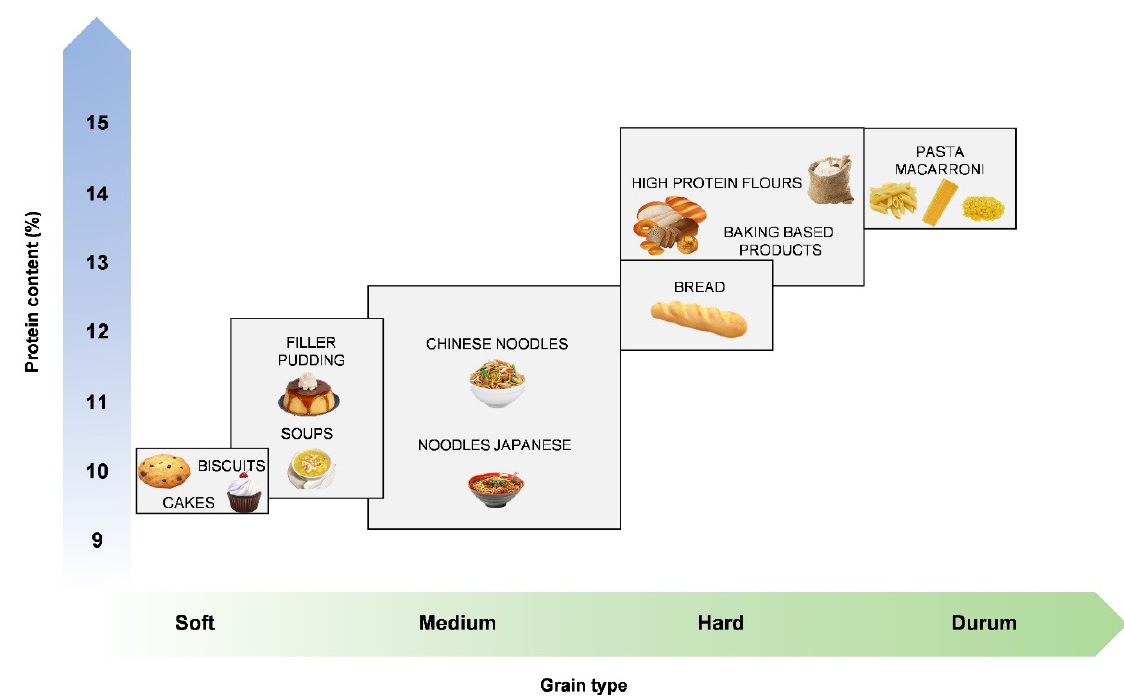
Figure 4. Examples of the most appropriated varieties according to the hardness of the grain and protein content for specific final products.